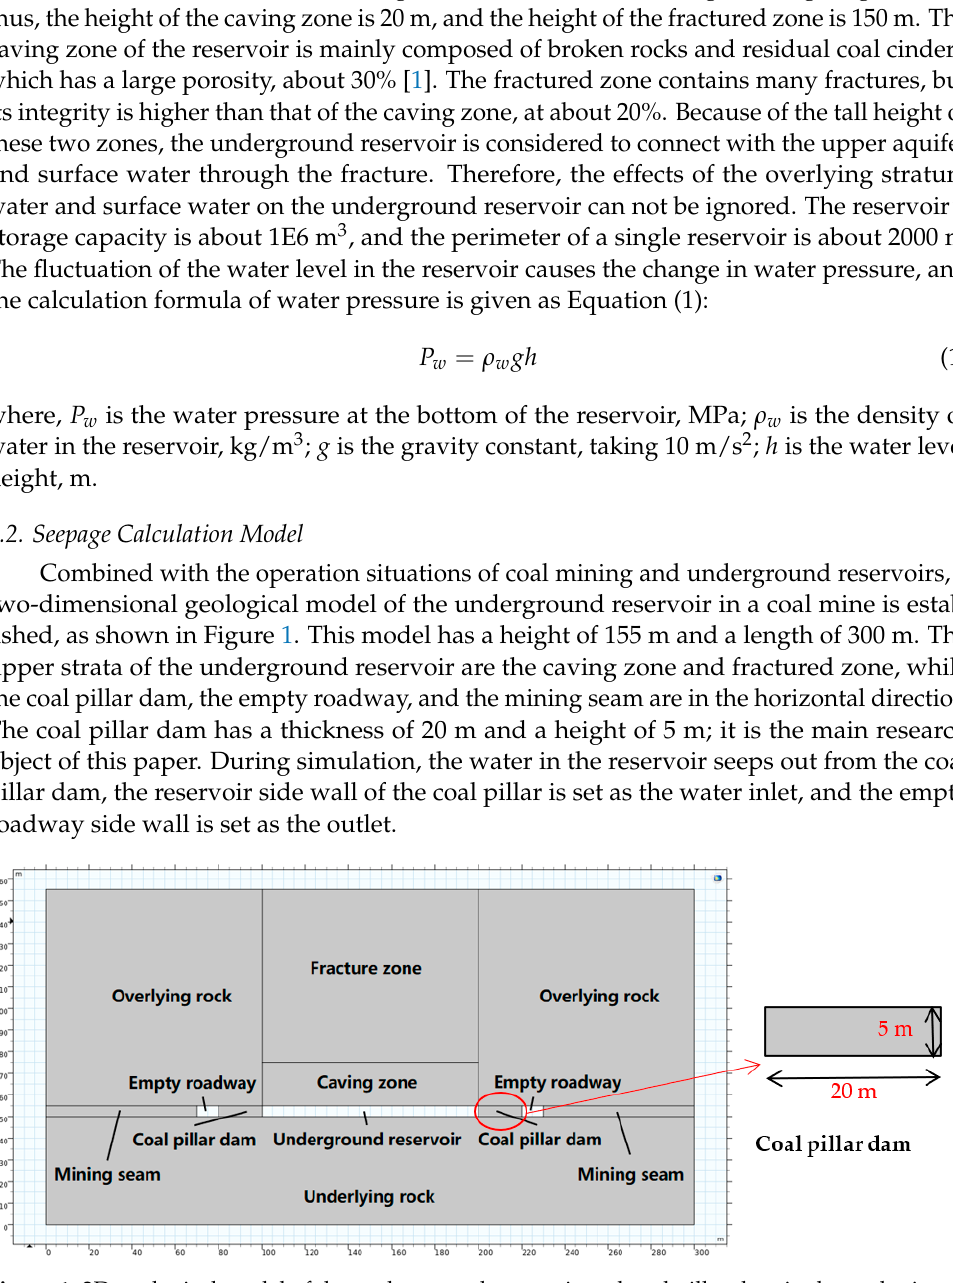
Figure 1. 2D geological model of the underground reservoir and coal pillar dam in the coal mine.